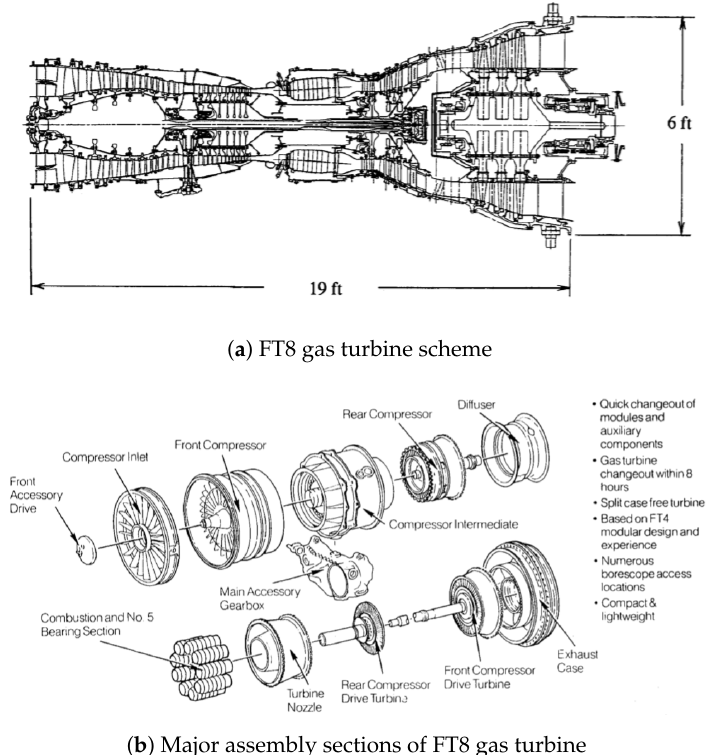
Figure 1. FT8 gas turbine